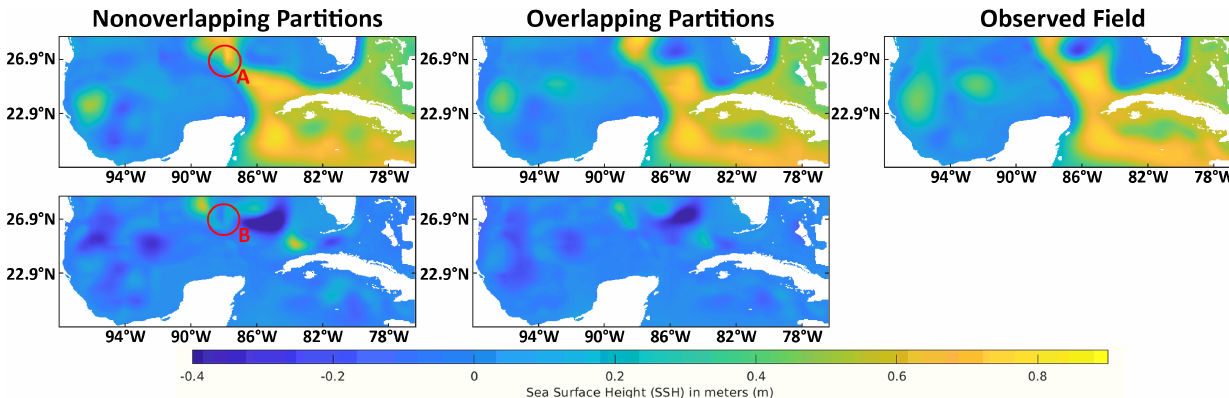
Figure 4. Another 10-week SSH forecast which shows that a discontinuity may contribute to misidentified shedding or significantly alter the predicted path of an eddy. The bottom row of the figure shows the difference plot between the prediction and ground truth observation. Note that in (A) we can clearly see that the information from the right-partition was unable to be properly relayed the left. As a result, in the error plot (B), we can see that there is a sharp valley signally that the discontinuity prevented what could have been an eddy formation event and significantly altering its future path.